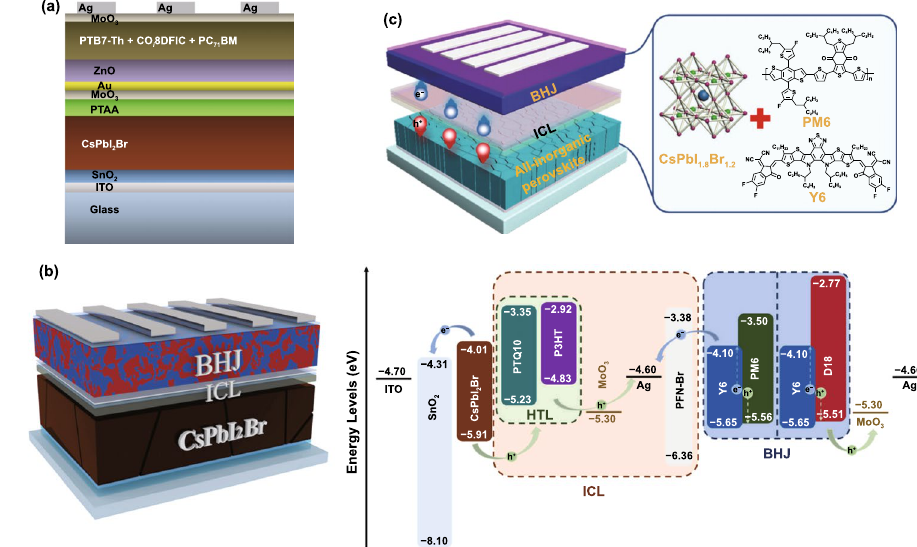
Fig. 6 a Schematic for 2-T perovskite/organic TSC. Reproduced with permission from Ref. [117]. Copyright 2019, Elsevier. b Device structure and energy levels diagram of CsPbI 2 Br/organic TSC. Reproduced with permission from Ref. [119]. Copyright 2022, Elsevier. c Left: device structure of all-inorganic perovskite/organic TSC. Right: crystal structure of CsPbI 1.8 Br 1.2 perovskite and the molecular structures of the donor and acceptor materials. Reproduced with permission from Ref. [120]. Copyright 2022,